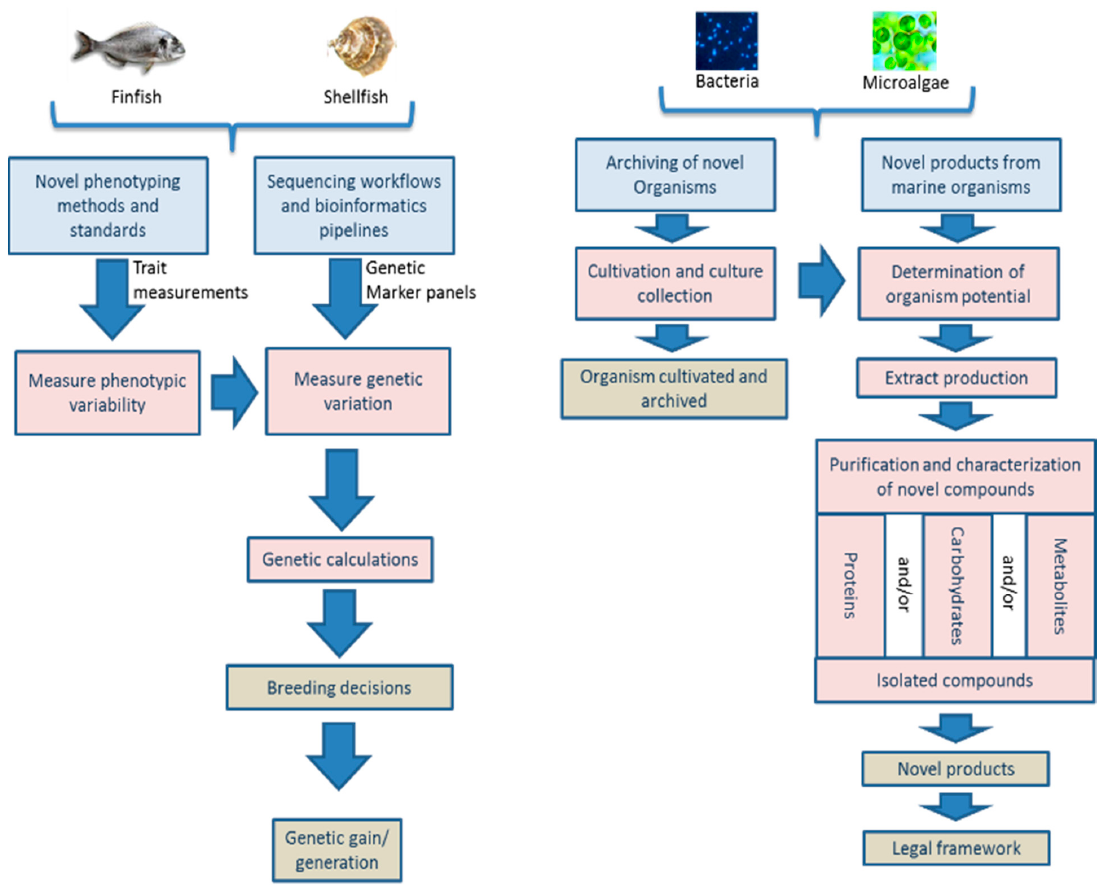
Figure 1. The EMBRIC pilot discovery pipelines in aquaculture genetics and breeding, and discovery and exploitation of marine natural products from microalgae and marine microbes. Table 1. European Research Infrastructures participating in EMBRIC and their respective fields of